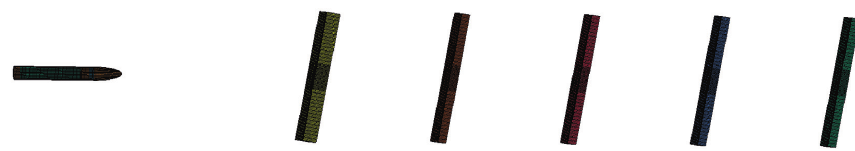
Figure 9: Finite element